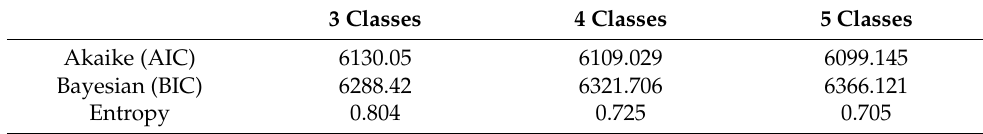
Table 3. Model fit indices by latent class.